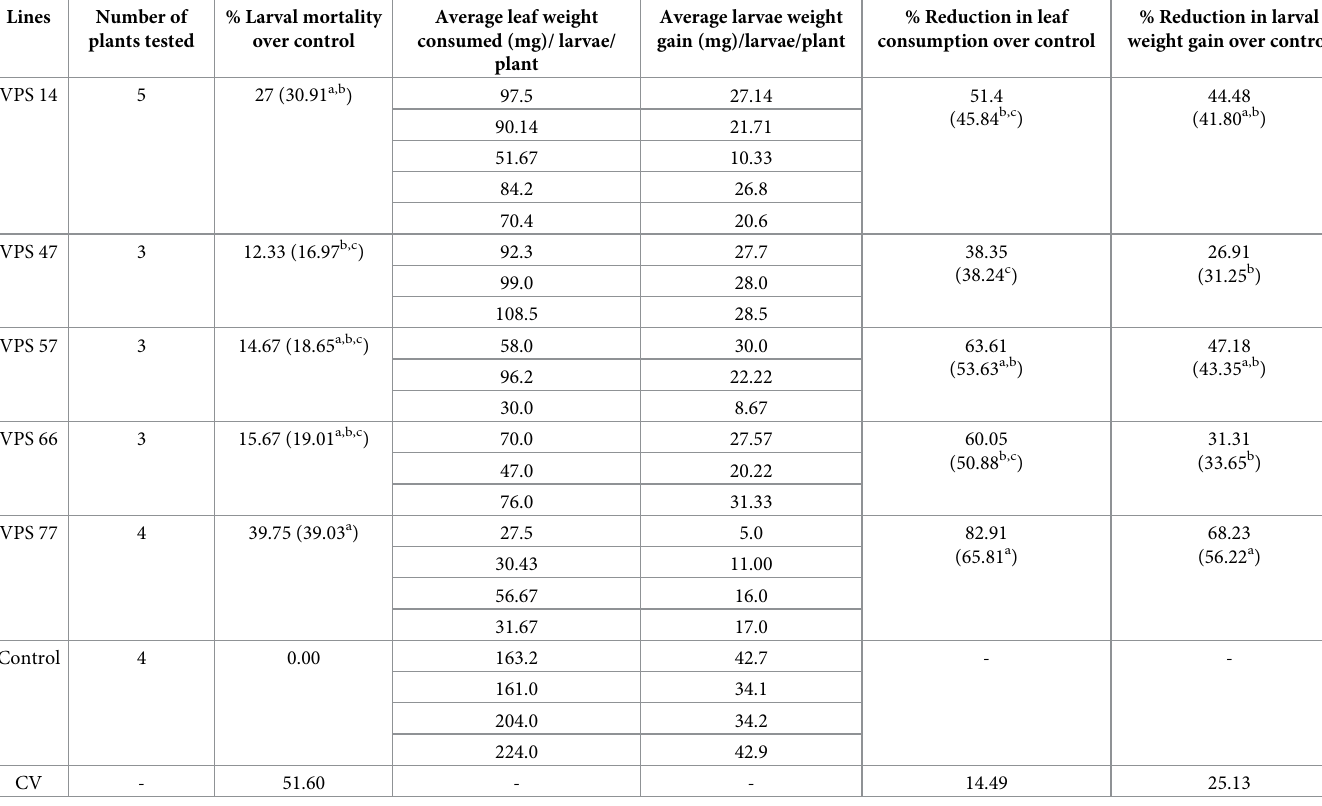
Table 1. Efficacy of tested transgenic chickpea lines against H . armigera . Lines